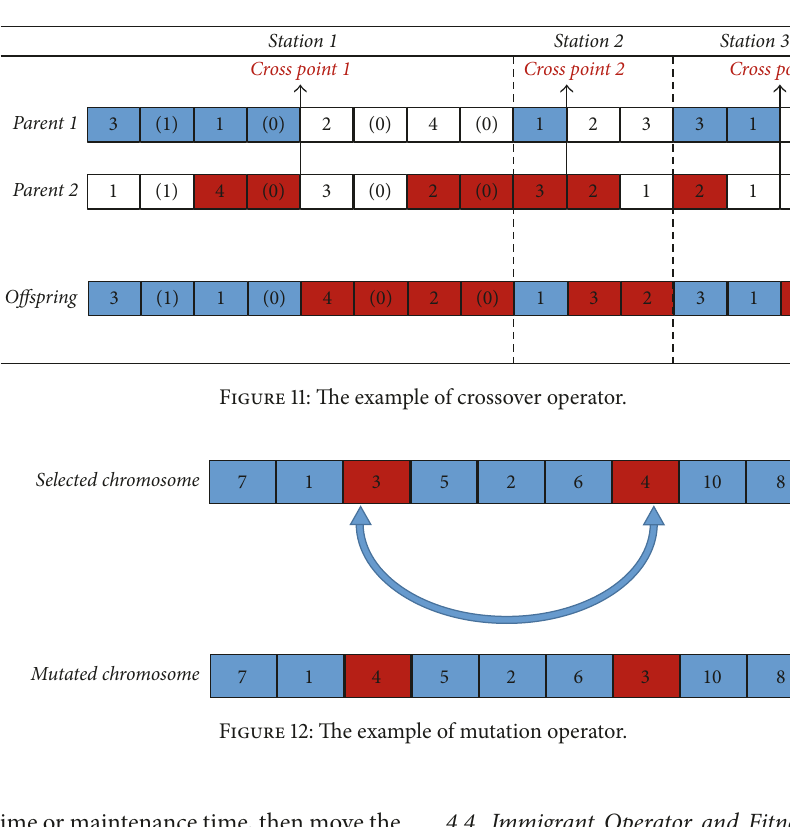
Figure 10: The solution representation of three stations.